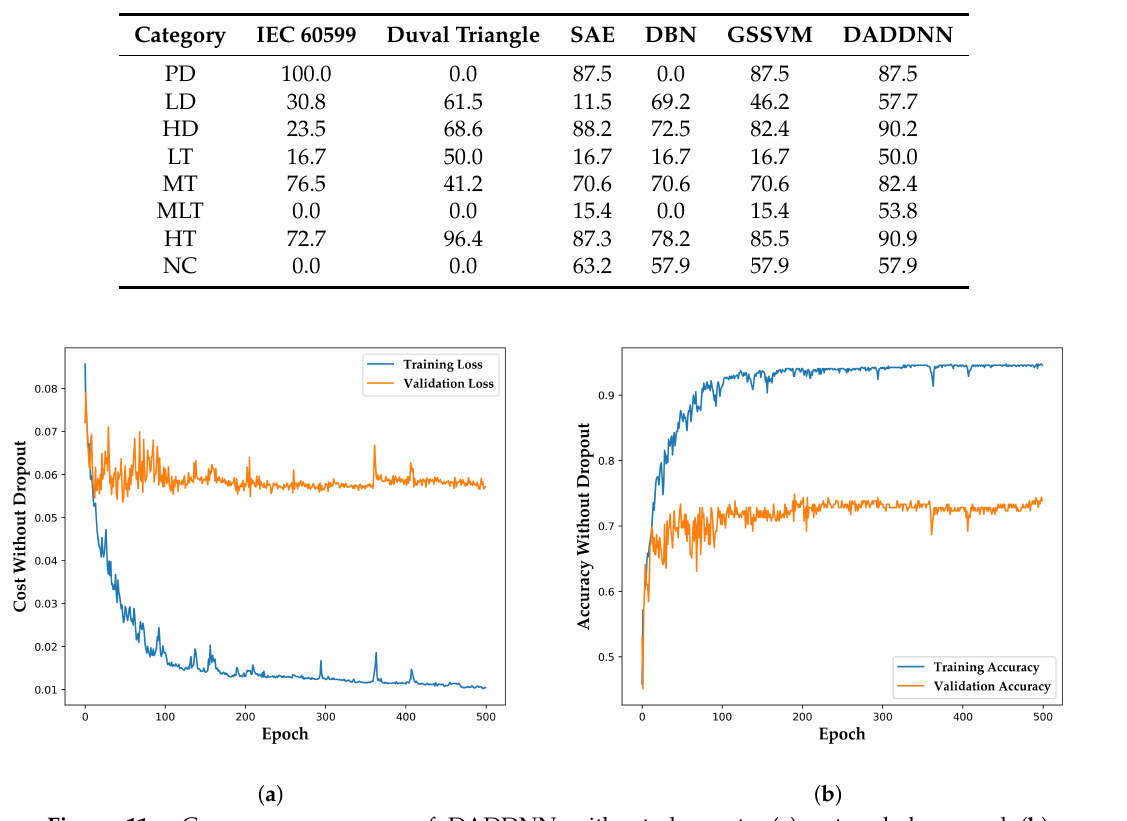
Table 3. Diagnosis accuracy of each fault category in Total dataset (%).